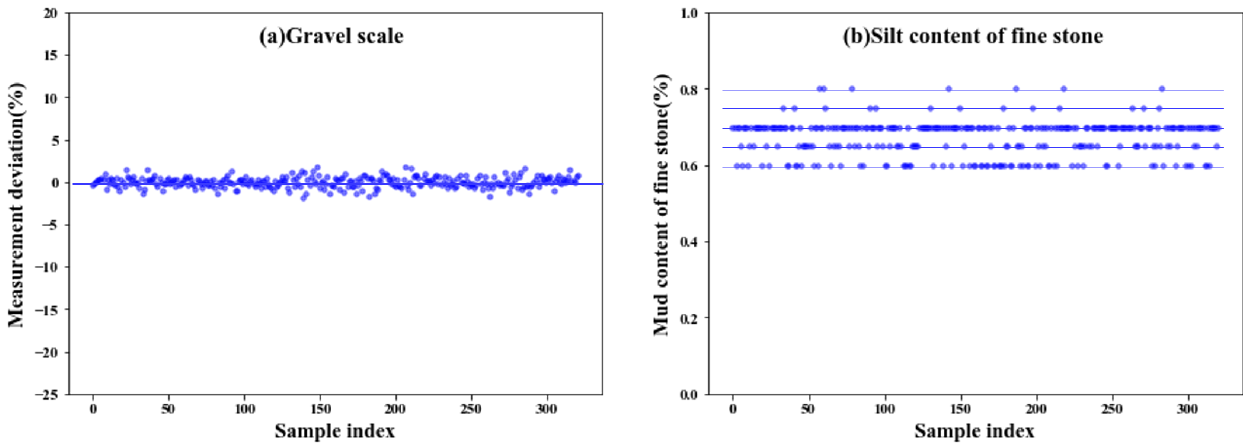
Figure 10. Data distribution of two of the excluded unimportant process factors: ( a ) weighting error of gravel weighting scale, and ( b ) the silt content of fine